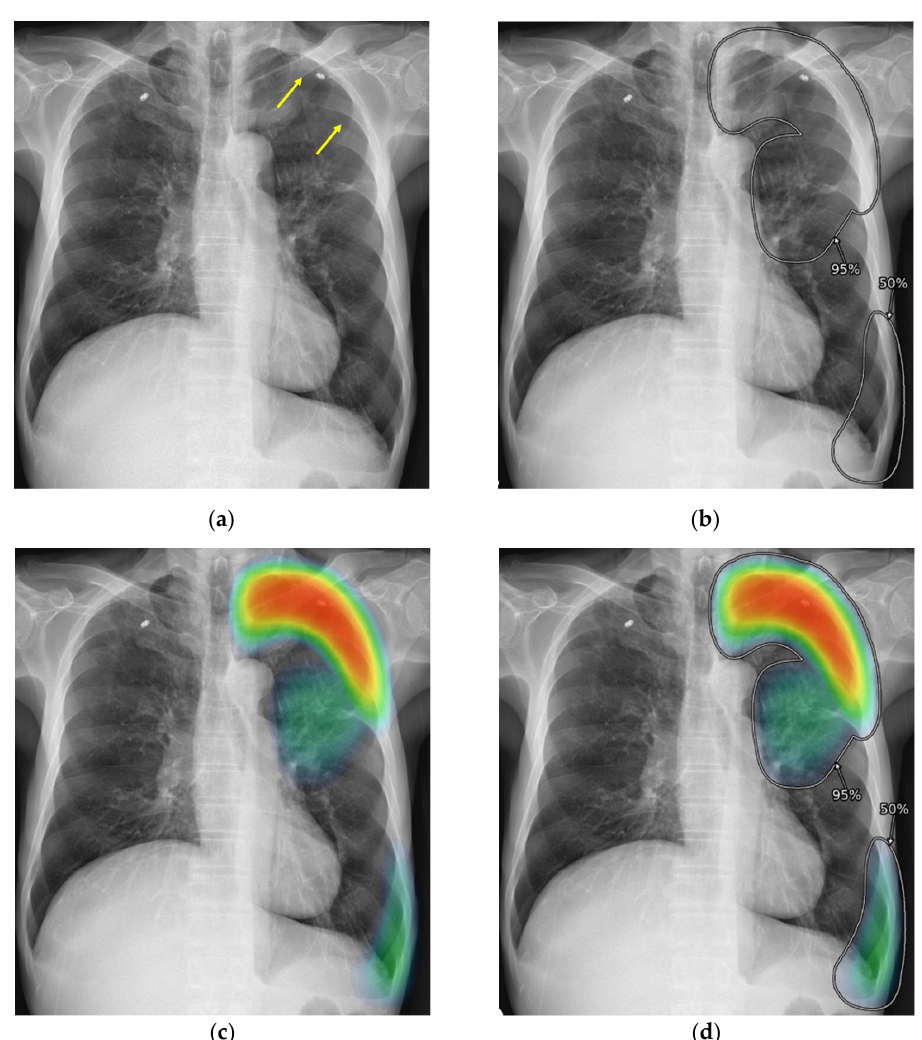
Figure 1. Representative examples showing that the advantages of the heat map method can complement the disadvantage of the closed-line method. ( a ) Chest radiography of a 75-year-old man who visited an emergency department with chest pain showed right pneumothorax (arrows). The artificial-intelligence-based computer-aided detection (AI-CAD) detected pneumothorax with a probability score of 95%. With visualization of AI-CAD result by closed-line method ( b ), one of five radiologists missed the pneumothorax. Meanwhile, with heat map method ( c ) and combined method ( d ), all five trainee radiologists identified the abnormality.